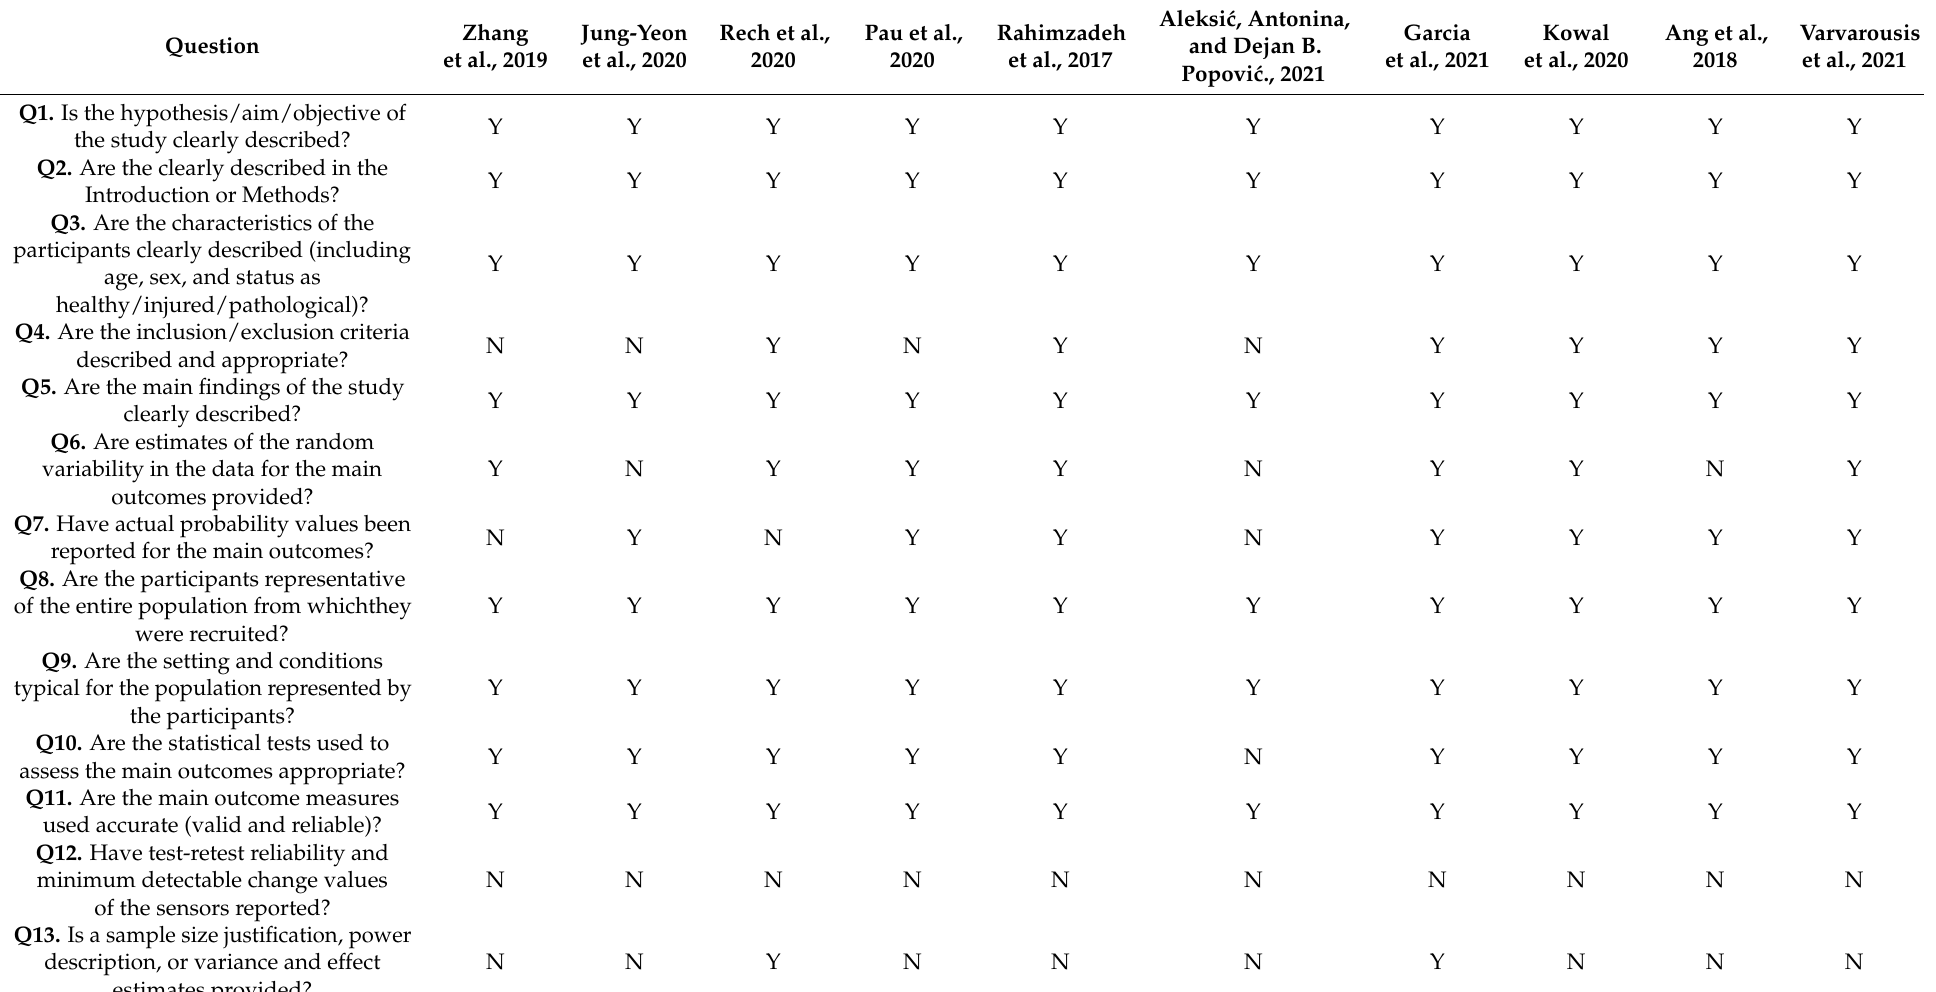
Table 3. Quality assessment